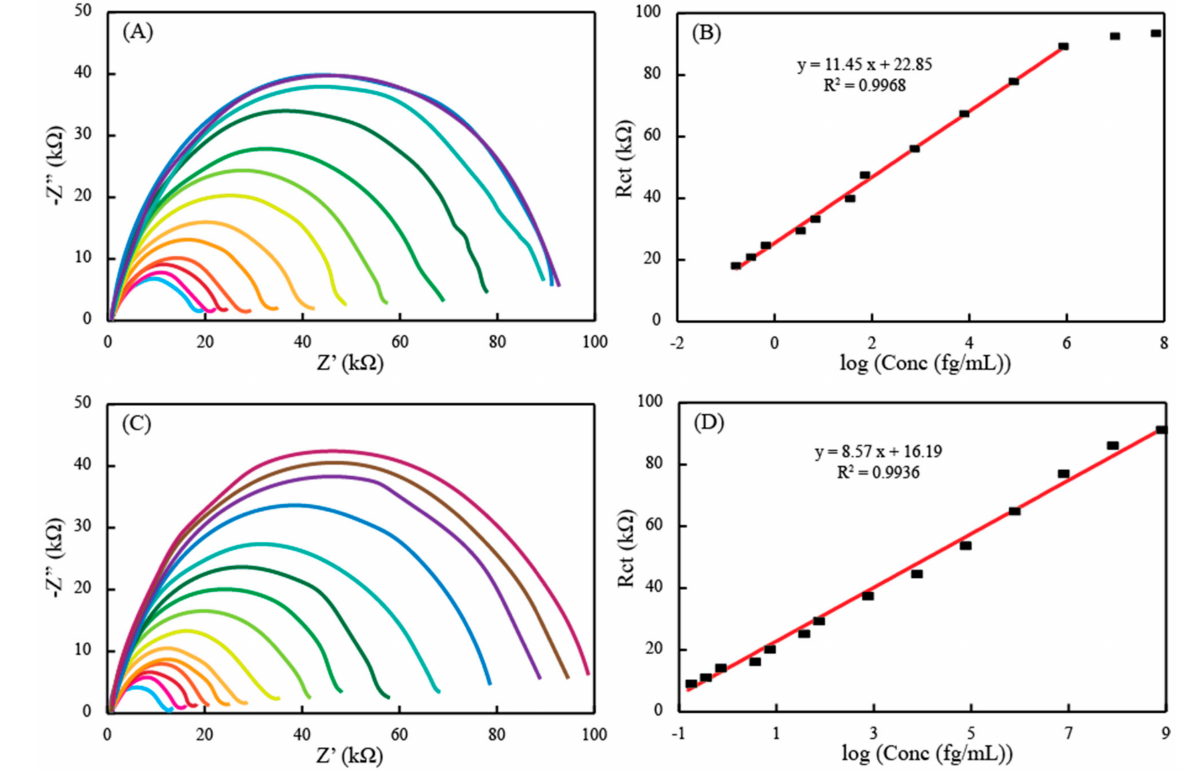
Figure 4. The sensor response of different concentrations of the RBD spiked directly in diluted nasopharyngeal samples and the corresponding calibration plots, obtained with the linear regression equation shown here, ( A ) represents the concentrations in the range of 0.25 fg/mL to 100 ng/mL measured using the PBASE-mediated antibody immobilized electrode on graphene with ( B ) as its calibration plot and ( C ) represents the concentrations in the range of 0.25 fg/mL to